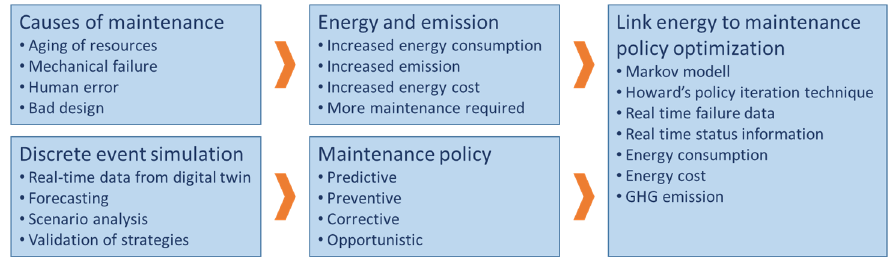
Figure 1. Summary of background assumptions from the linkage of maintenance and energy point of view.